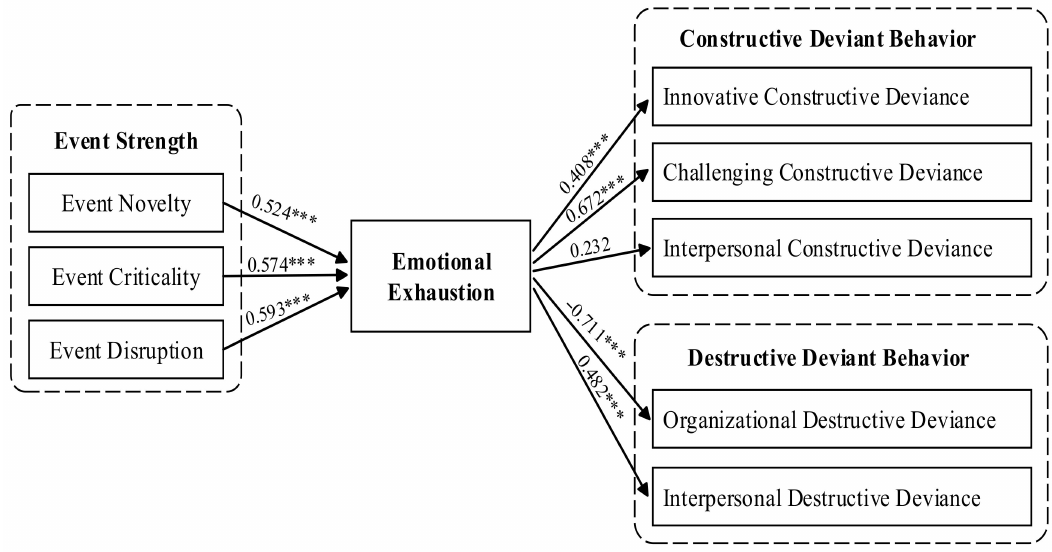
Figure 2. Path test results of the theoretical model; *** p < 0.001.